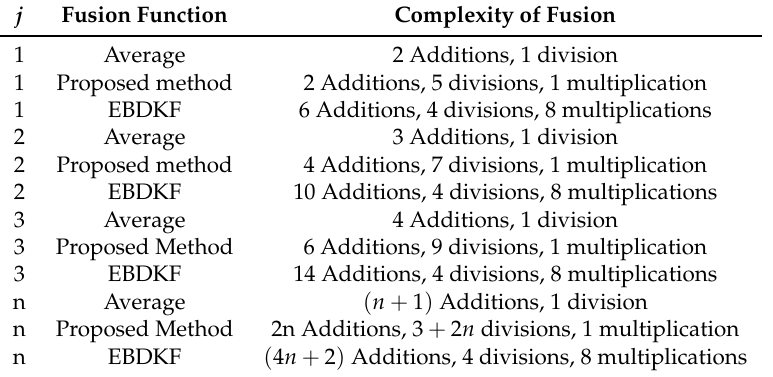
Table 5. Average fusion complexity per node for different information fusion functions in a bidirectional